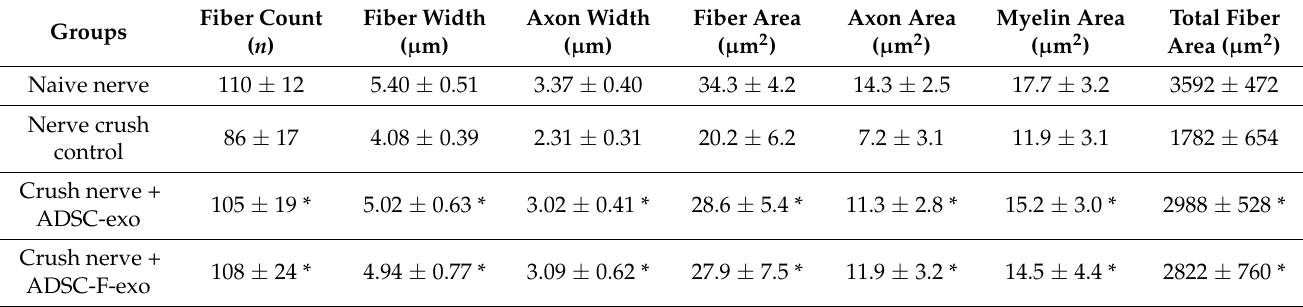
Data are shown as mean ± standard error (* indicated p < 0.05 when compared to those of crush